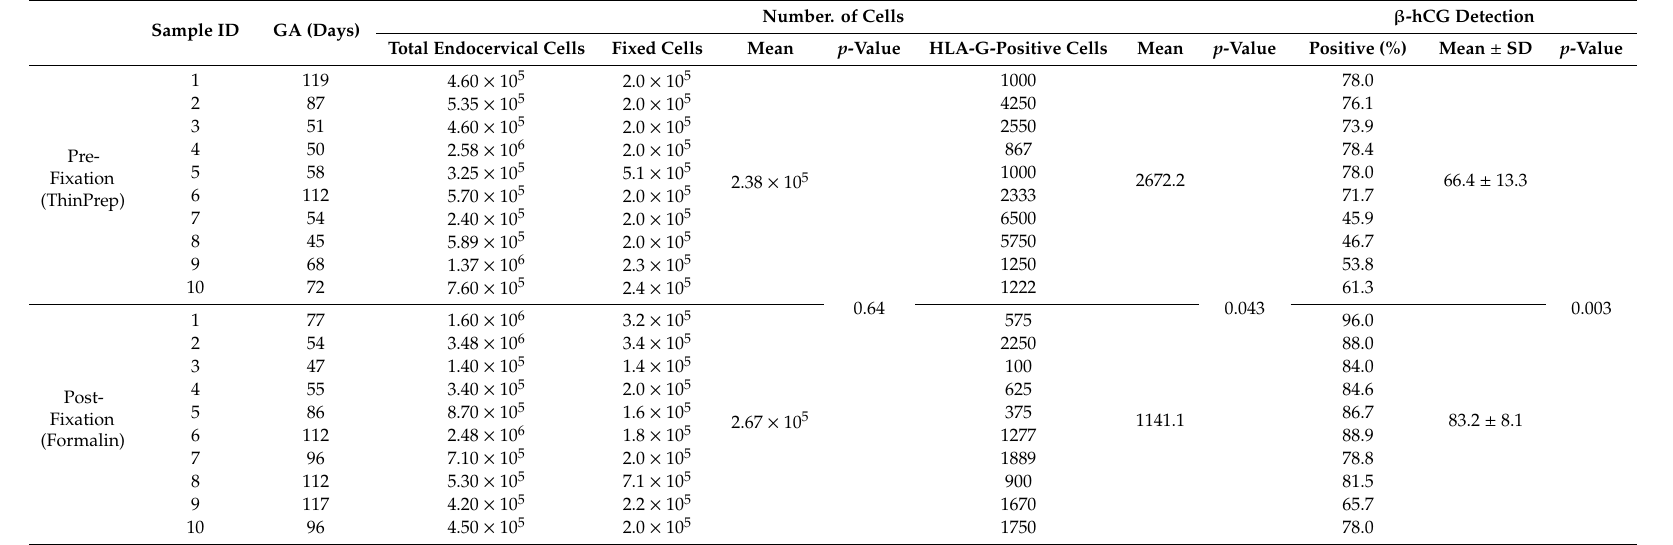
Table 2. Trophoblast contents and detection of β